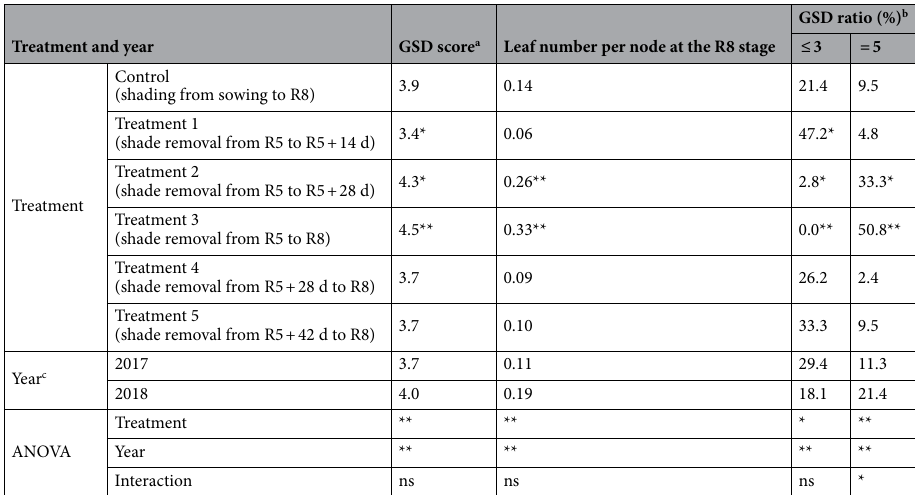
Table 2. Effects of the time and duration of shade removal on GSD severity. Dunnett test was used for the comparisons within each column and between the control and other treatments. **Significantly different ( p < 0.01). *Significantly different ( p < 0.05). a ANOVA and Dunnett test were conducted after Box-Cox transformation. b ANOVA and Dunnett test were conducted after angular transformation. c Average score of all treatments in each year. Statistical analyses were performed using the statistical software BellCurve for Excel version 3.21.